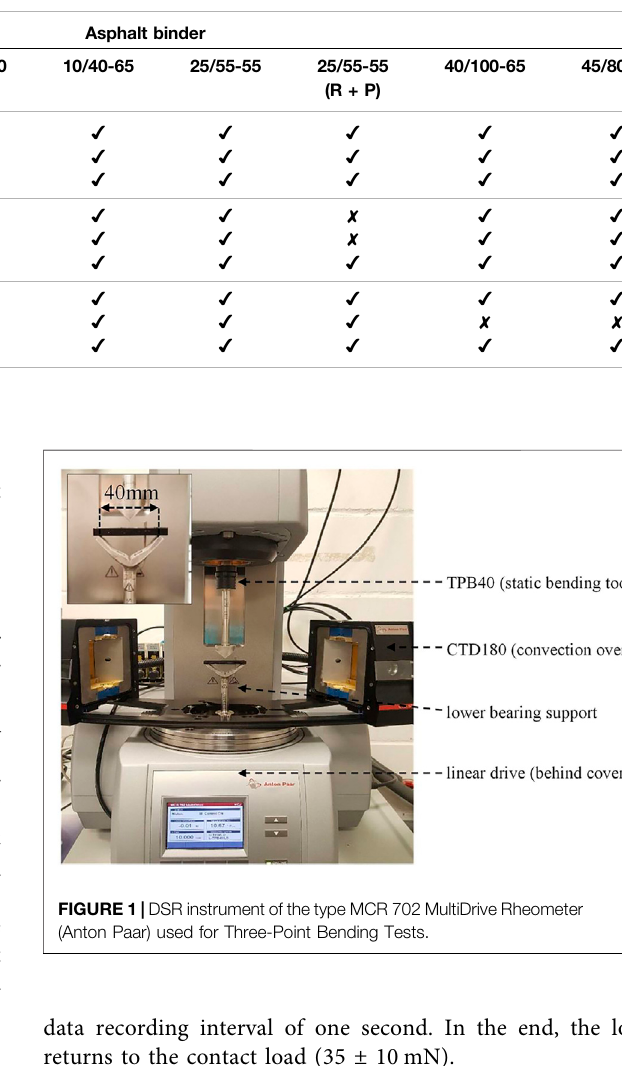
data recording interval of one second. In the end, the load returns to the contact load (35 ± 10 mN).